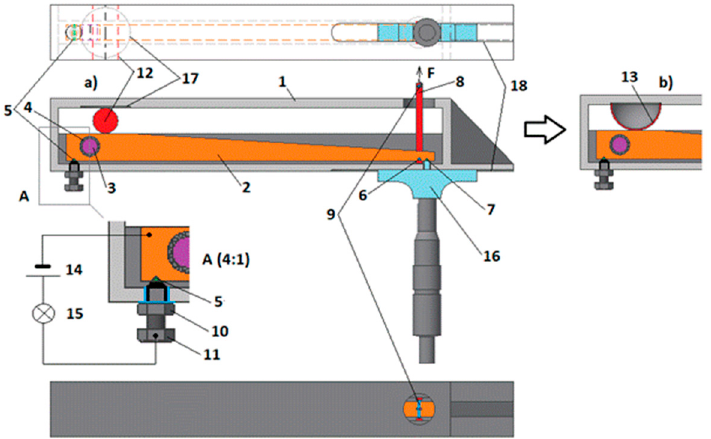
Figure 6. Scheme of a measuring unit for determination of the Young modulus of ball joint bearing; ( a ) During determining the initial position of the screw with fine thread isolated relatively to the support relatively to the latter; ( b ) During measurement of deformation of the polymer-bearing material sample tested. 1—support, 2—tilt arm, 3—pin (needle bearing shaft), 4—bearing needle, 5—needle, 6—pin of hoop of a loading unit assembly with weights, 7—bearing needle, 8—cord of hoop of a loading unit assembly with weights, 9—pin of hoop connected to the string of the weights’ holder, 10—nut isolated relatively to the support, 11—screw with fine thread isolated relatively to the support, 12—aligning bearing roller, 13—tested bearing material sample, 14—battery, 15—control light, 16—depth gauge micrometer, 17—seat in the support for positioning of tested bearing material sample, 18—seat in the support for positioning of depth gauge micrometer, F—loading force from weights, A—detailed view.